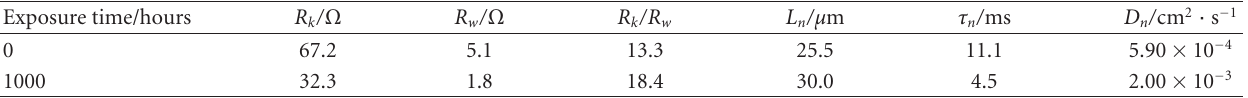
Table 1: Parameters determined by fitting the EIS experimental data of device A to the equivalent circuit as shown in Figure 5. Exposure